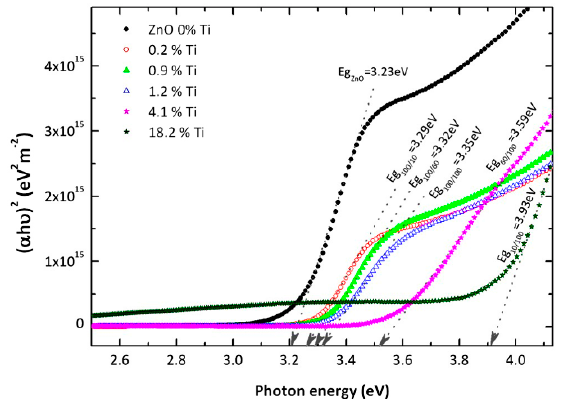
Figure 7. The variation in the ( α h ν ) 2 values as a function of energy for ZnO films with different concentrations of Ti incorporation (from 0 to 18.2 at.%).